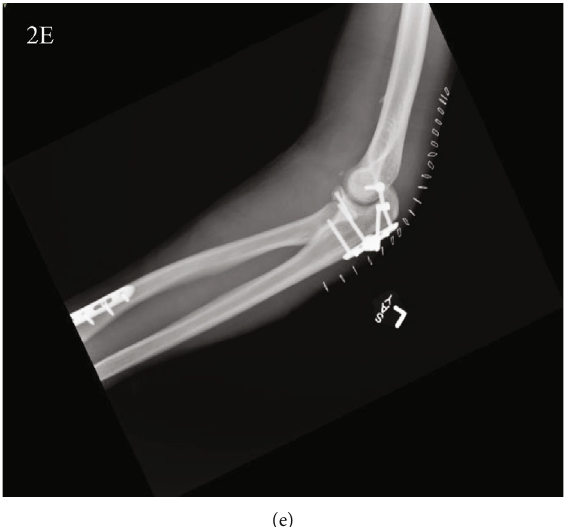
Figure 2: Postoperative radiographs of the plate fi xation in the left wrist PA (a), lateral rotation (b), and external rotation (c) along with postoperative AP (d) and lateral radiographs (e) of the left elbow showing IJS